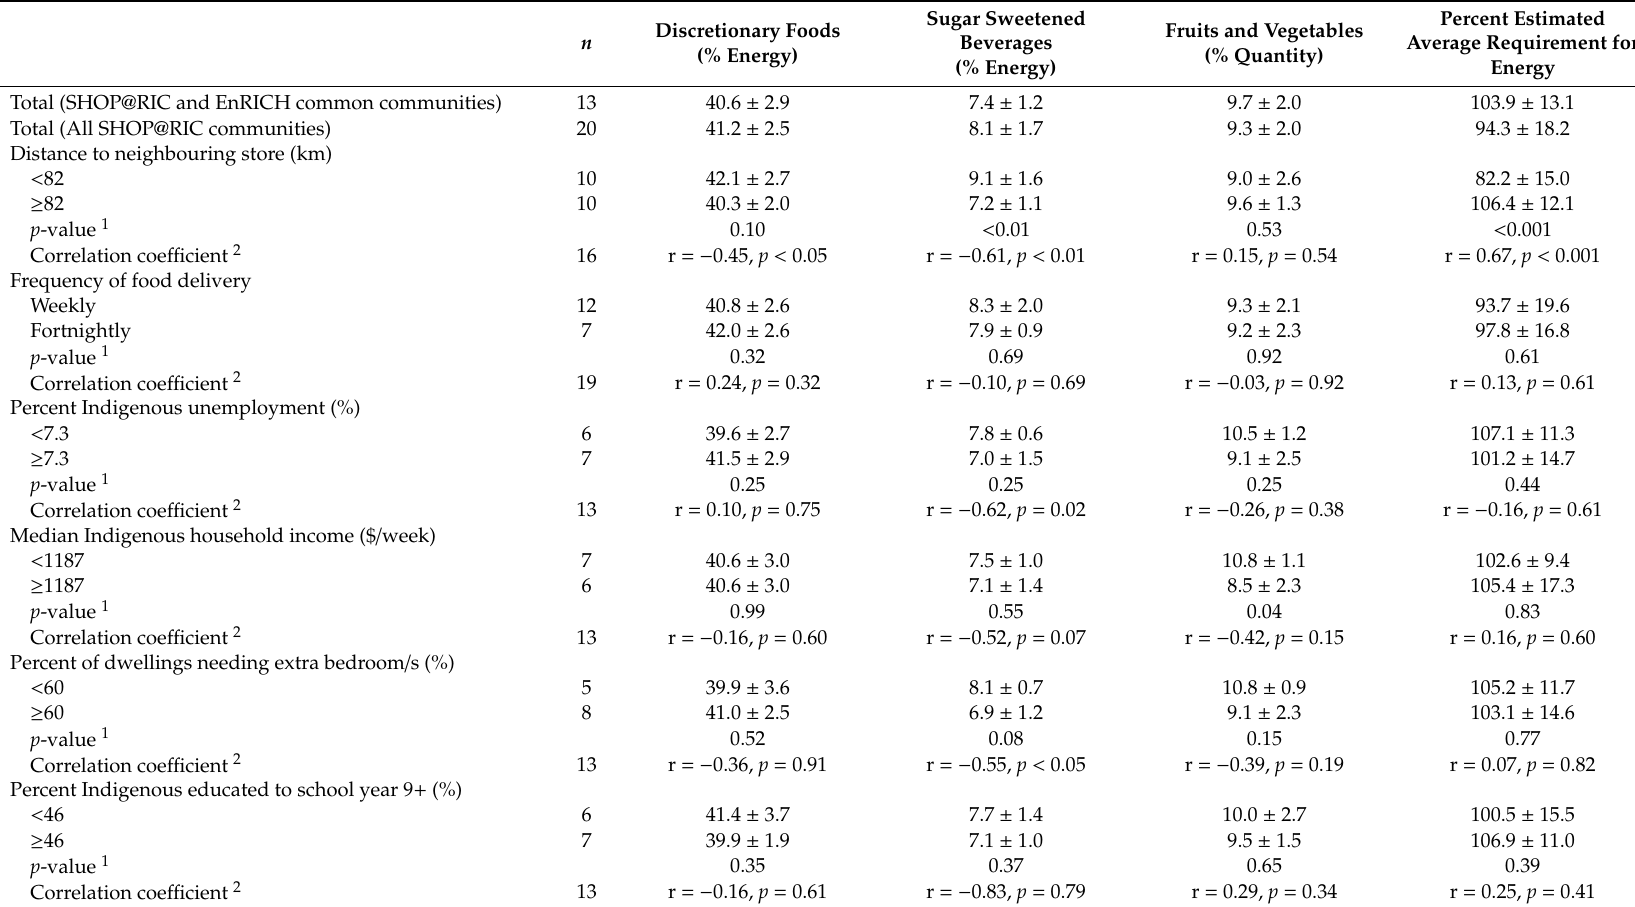
Table 1. Associations between dietary intake features associated with cardio-metabolic disease risk and environmental-level factors.